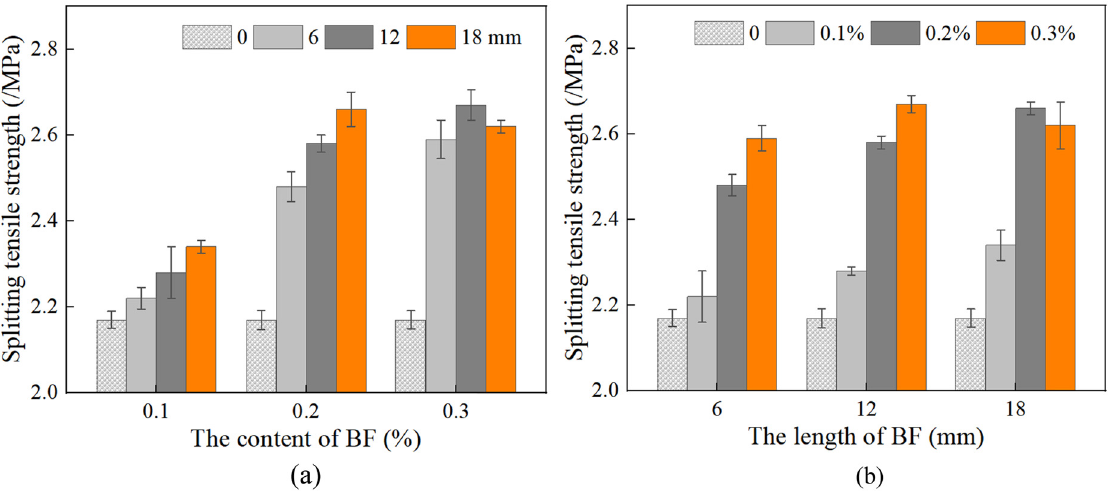
Figure 11: E ff ect of BF on the splitting tensile strength of RAC. ( a ) RAC with di ff erent BF contents. ( b ) RAC with di ff erent BF